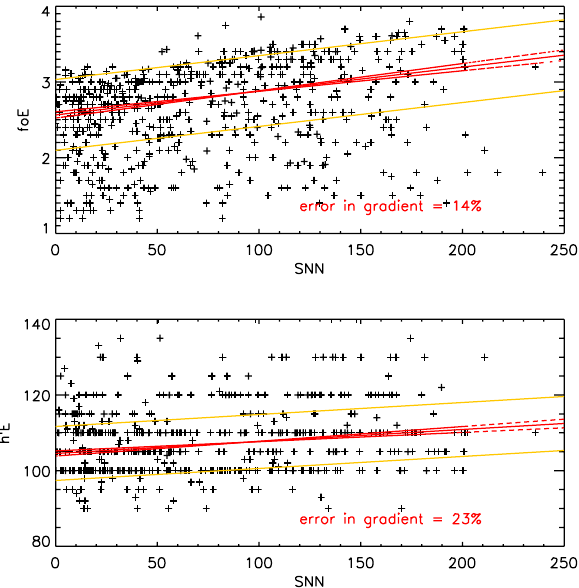
Fig. 1. Monthly medians of mid-day values of f oE (upper panel) and h 0 E (lower panel).